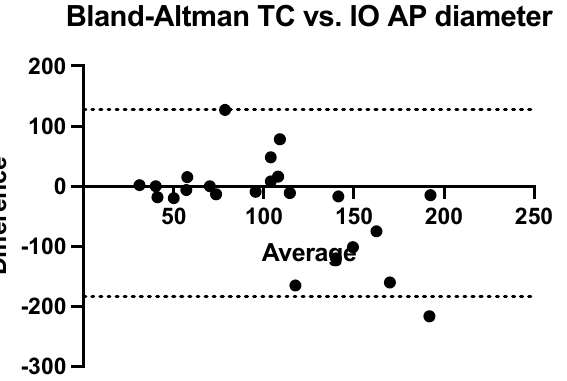
Figure 5. Bland-Altman analysis comparing anteroposterior diameter measured using ultrasound versus intraoperative measurement (US = ultrasound, IO = intraoperatively).